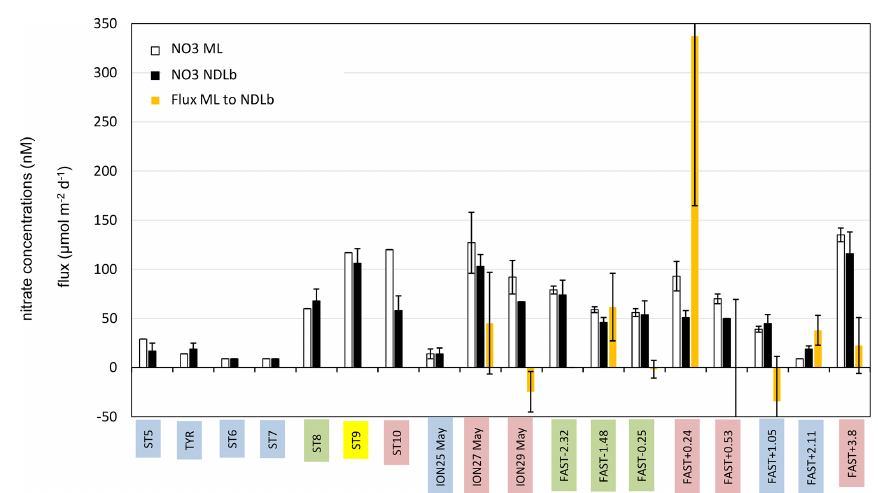
Figure 4. Average concentration of nitrate (NO3) in the ML and NDLb and NO3 flux from the ML into the NDLb. The stations have been classified into four groups (1 in blue, 2 in green, 3 in yellow, 4 in red; see Sect. 3, Results, and Table S1 for definitions). Error bars indicate standard deviation around mean values for nitrate concentrations and error propagation for the flux from the ML to NDLb calculated using a 0.5m uncertainty in the MLD